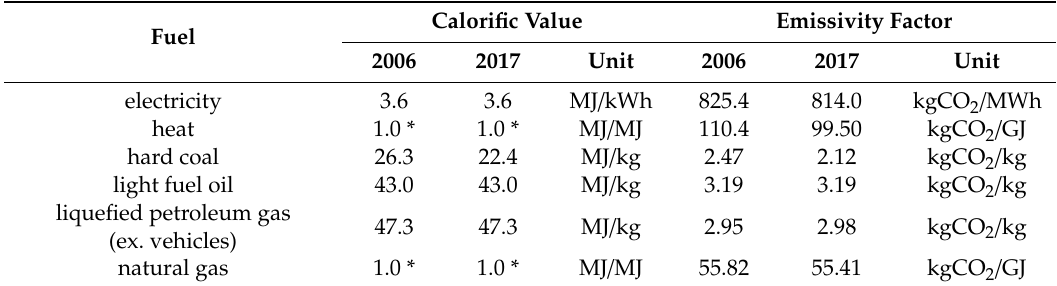
Table 4. Indicators related to CO 2 emission intensity in households in 2017. Source: Own calculation. Emission per Region Capita [t]